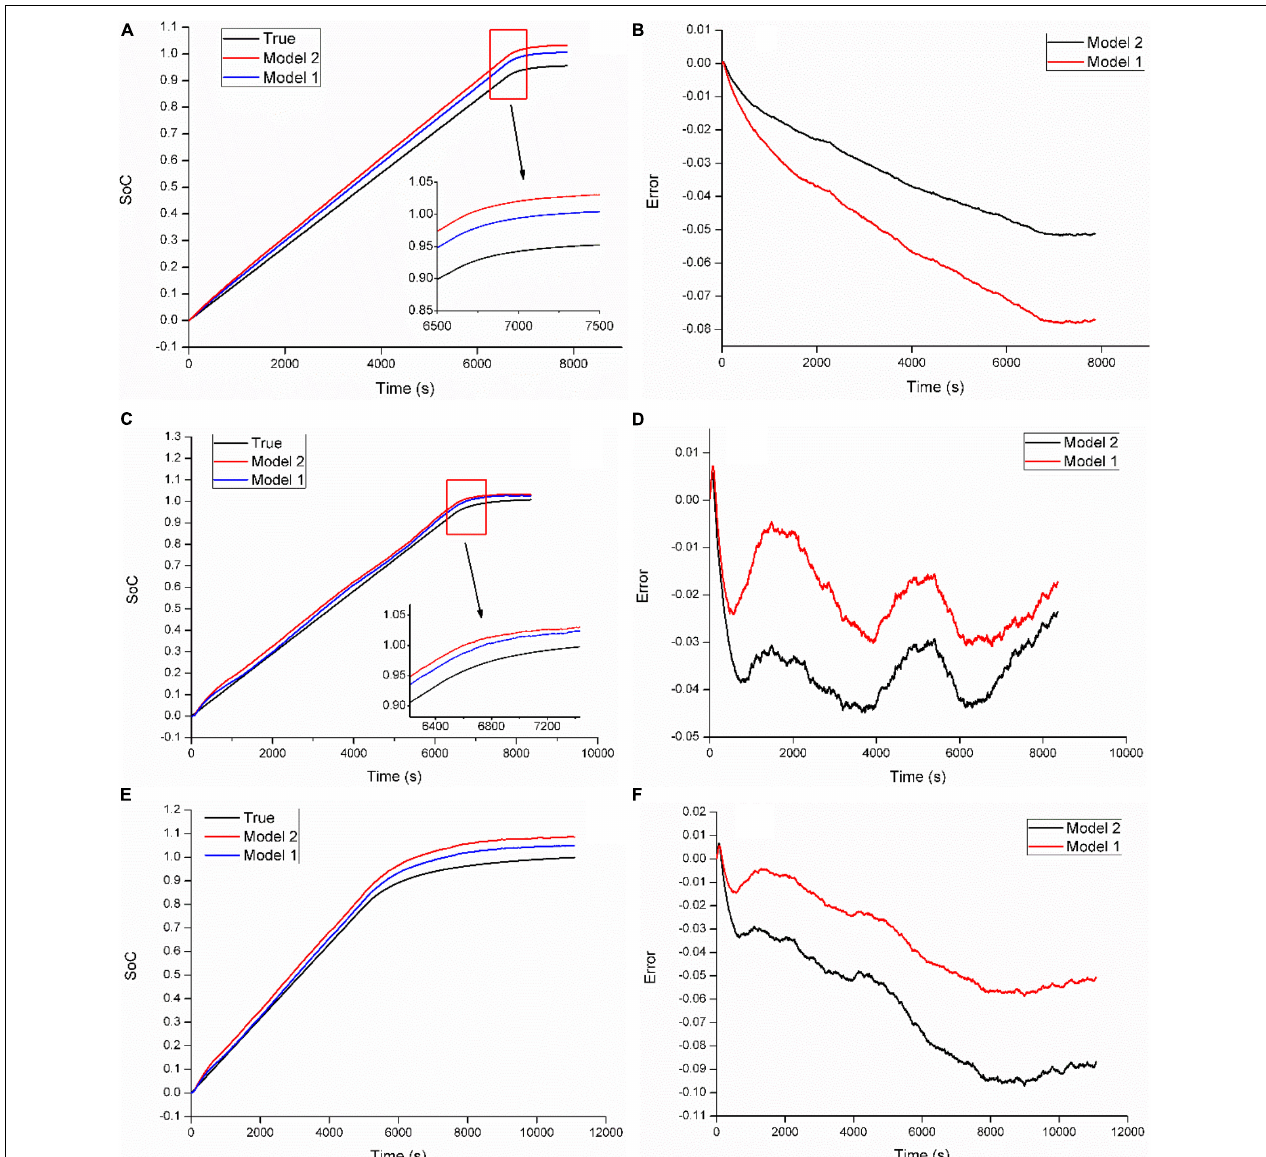
FIGURE 11 | Estimation results based on model 1 and model 2 at three temperatures via the CCCVC. (A) Estimated SoCs at 40 ◦ C; (B) estimation errors at 40 ◦ C; (C) estimated SoCs at 22 ◦ C; (D) estimation errors at 22 ◦ C; (E) estimated SoCs at 0 ◦ C; (F) estimation errors at 0 ◦ C.